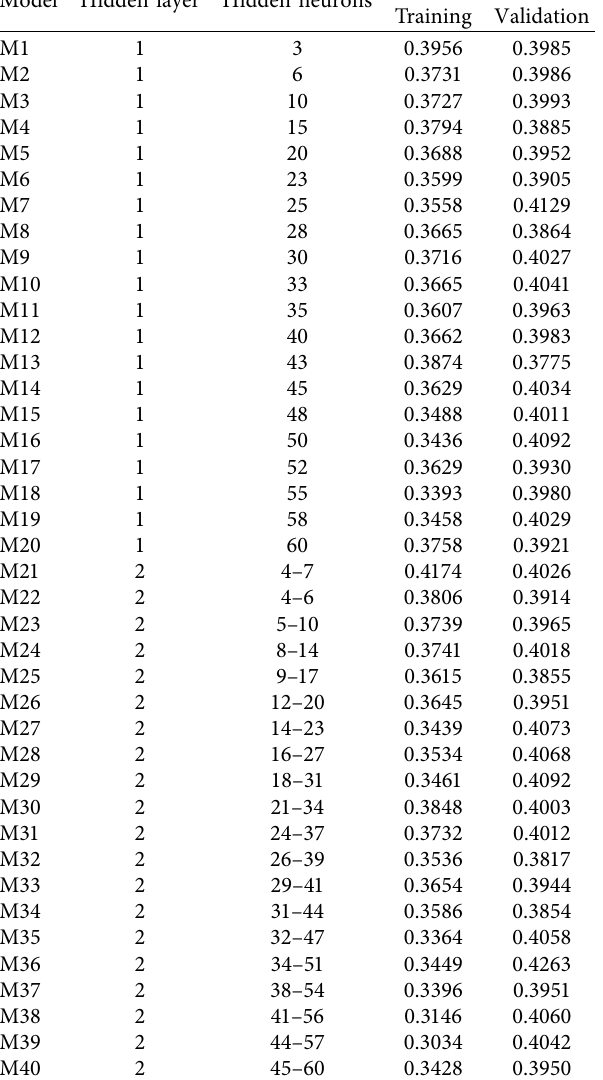
Table 17: Different ANN structures for the prediction of accident severity. Model Hidden layer Hidden